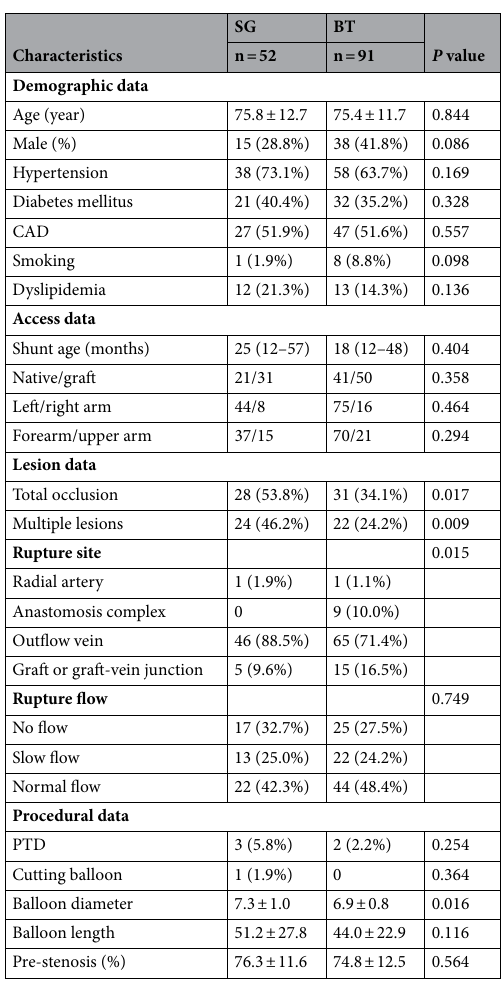
Table 1. Baseline characteristics of study participants according to treatment group. Values are expressed as n (%), mean ± SD, or median (IQR). SG stent graft, BT balloon tamponade, CAD coronary artery disease, PTD percutaneous thrombectomy